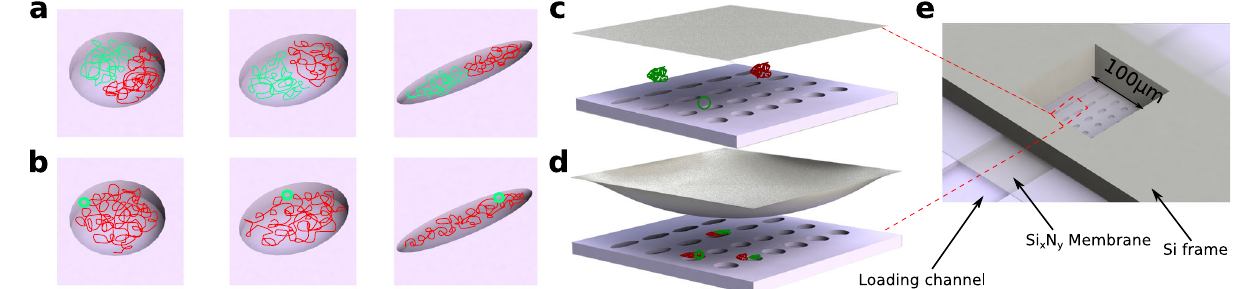
Fig. 1 Schematic of the experimental concept and setup. a Schematic of two differentially stained equal-sized dsDNA molecules con fi ned in elliptical compartments of varying eccentricity. b Schematic of a larger dsDNA molecule and a plasmid molecule con fi ned in the same structures. c , d Molecular con fi nement is induced mechanically by using pneumatic pressure to depress a thin membrane lid. Depression of the lid traps the molecules in nanoscale cavities embedded in the fl oor of a nanoslit fl ow-cell. e Zoomed-out view of device: the cavities are de fi ned in a nanoslit that is interfaced to the fl exible membrane lid at a central window etched through a supporting silicon